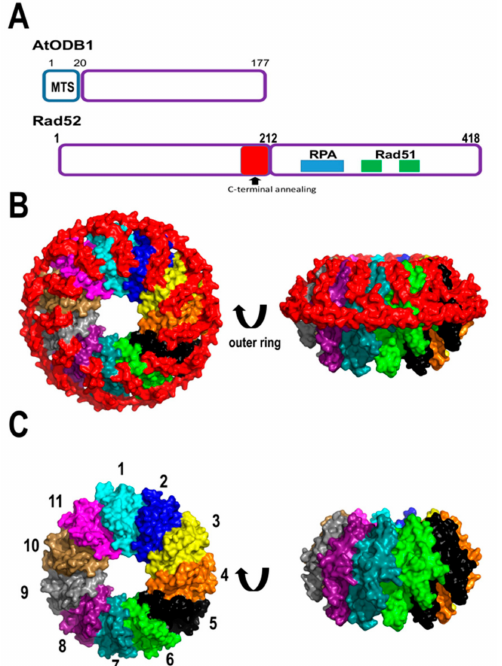
Figure 6. AtODB1 resembles human Rad52. ( A ) Structural domain organization of AtODB1 in comparison to human Rad52. AtODB1 lacks the C-terminal domain necessary to interact with RPA and Rad51; ( B ) crystal structure of the undecameric ring of human Rad52. The undecameric structure is stabilized by alpha-helix 5 that interacts with alpha-helix 1 of the neighbor molecule. Each subunit (residues 1 to 172 is individually colored) and the C-terminal residues (172 to 212) are colored in read. ( C ) Model of AtODB1 as a undecameric ring lacking alpha-helix 5 of human